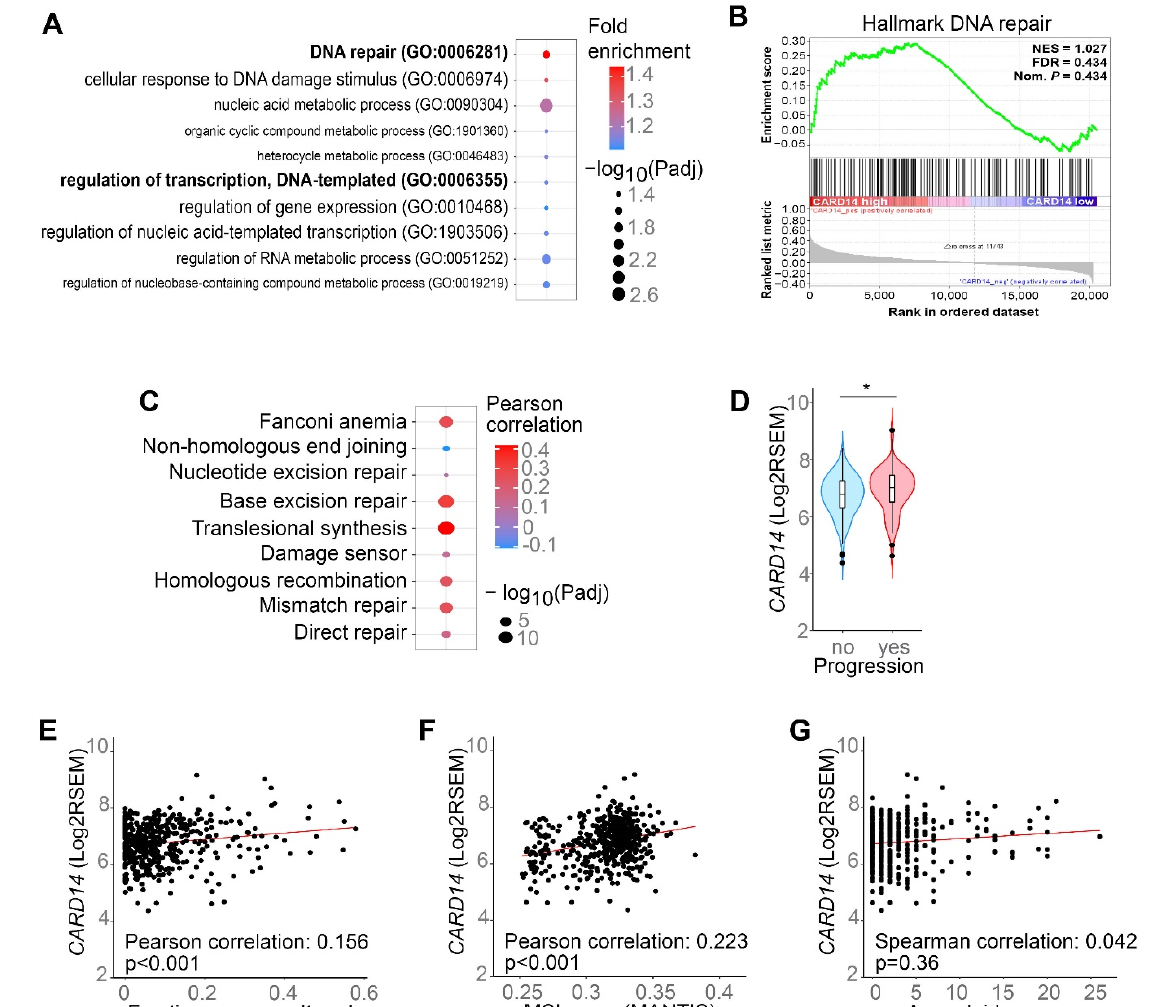
Figure 3. CARD14 expression correlates with DNA repair gene enrichment. ( A ) Gene ontology analysis for enrichment of biological processes on all genes whose expression showed a significant correlation with CARD14 expression based on gene expression (RSEM) in TCGA prostate adenocarcinoma (PRAD) patients. ( B ) Gene set enrichment analysis for enrichment of the Hallmark DNA repair gene set in genes ranked by positive correlation with CARD14 expression in TCGA PRAD patients (NES: Normalised Enrichment Score, FDR: False Discovery Rate). ( C ) Pearson correlation analysis between DNA damage response (DDR) pathway activity and CARD14 expression in TCGA PRAD patients. ( D – G ) CARD14 mRNA expression as a function of disease progression after radiotherapy ( D ), fraction genome altered ( E ), microsatellite instability ( F ) and aneuploidy score ( G ) in PCa patients, based on TCGA data. p value in ( D ) was generated by Welch t -test, * p < 0.05.